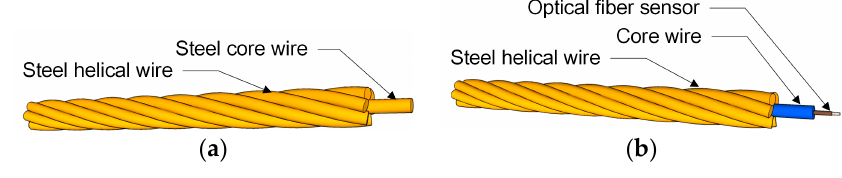
Figure 1. Composition of a seven-wire strand: ( a ) Steel strand; ( b ) Smart strand.